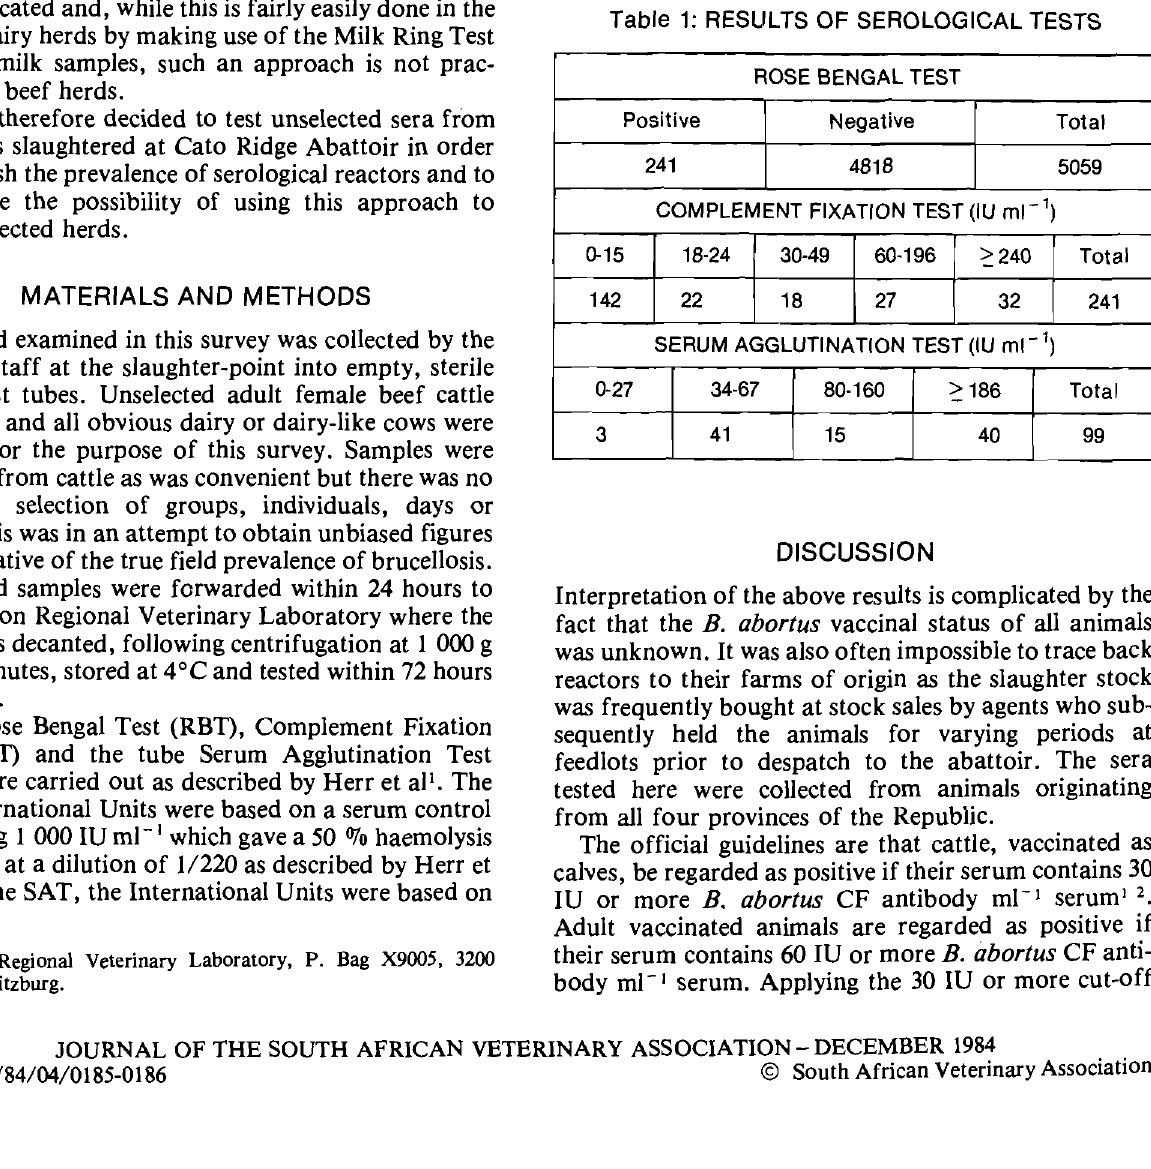
Table 1: RESULTS OF SEROLOGICAL